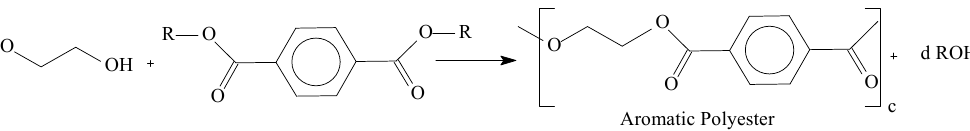
Figure 2. Transesterification reaction of a general aromatic diester and a diol. In Figure 2: “R” represents the ester carbonic chains, “c” means the number of repet- itive units from the polymeric chain, and letter “d” is the subproduct stoichiometric coef- ficient, which in this case is an aliphatic alcohol.